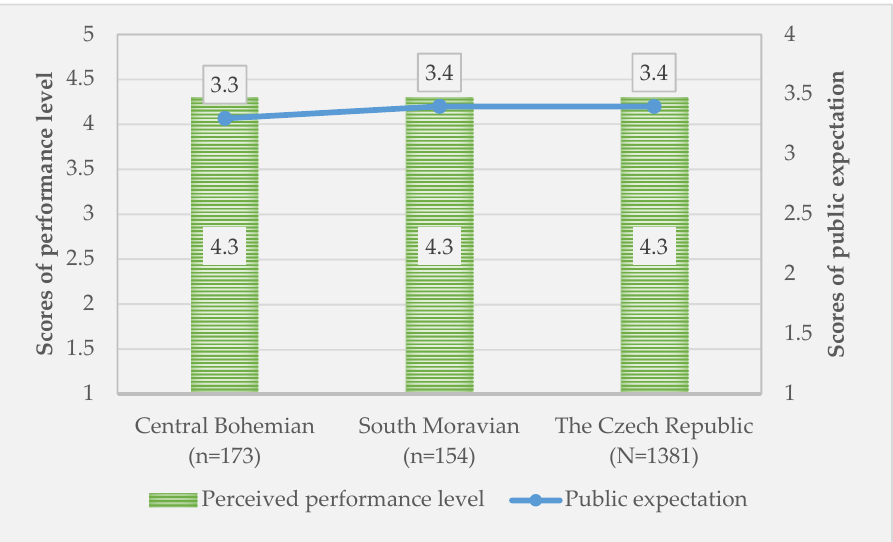
Figure 8. Mean of expectation and perceived performance level of the Czech forests on water provisioning services.